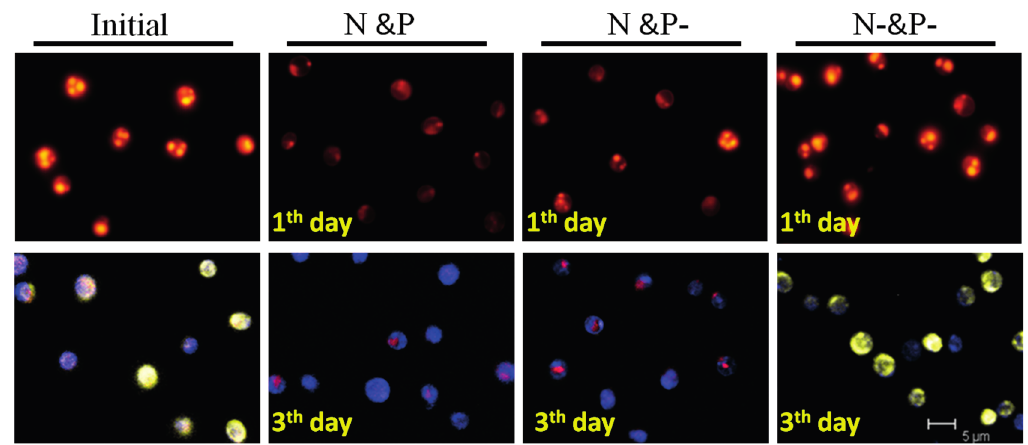
Figure 4. Observation of neutral lipid and Poly-P using Nile Red and DAPI staining. Above: The golden yellow fluorescence in the images indicates the presence of neutral lipid, and the red fluorescence is the autofluorescence of chlorophyll. Below: Blue fluorescence comes from nucleus staining, bright yellow fluorescence shows the Poly-P, and red fluorescence comes from